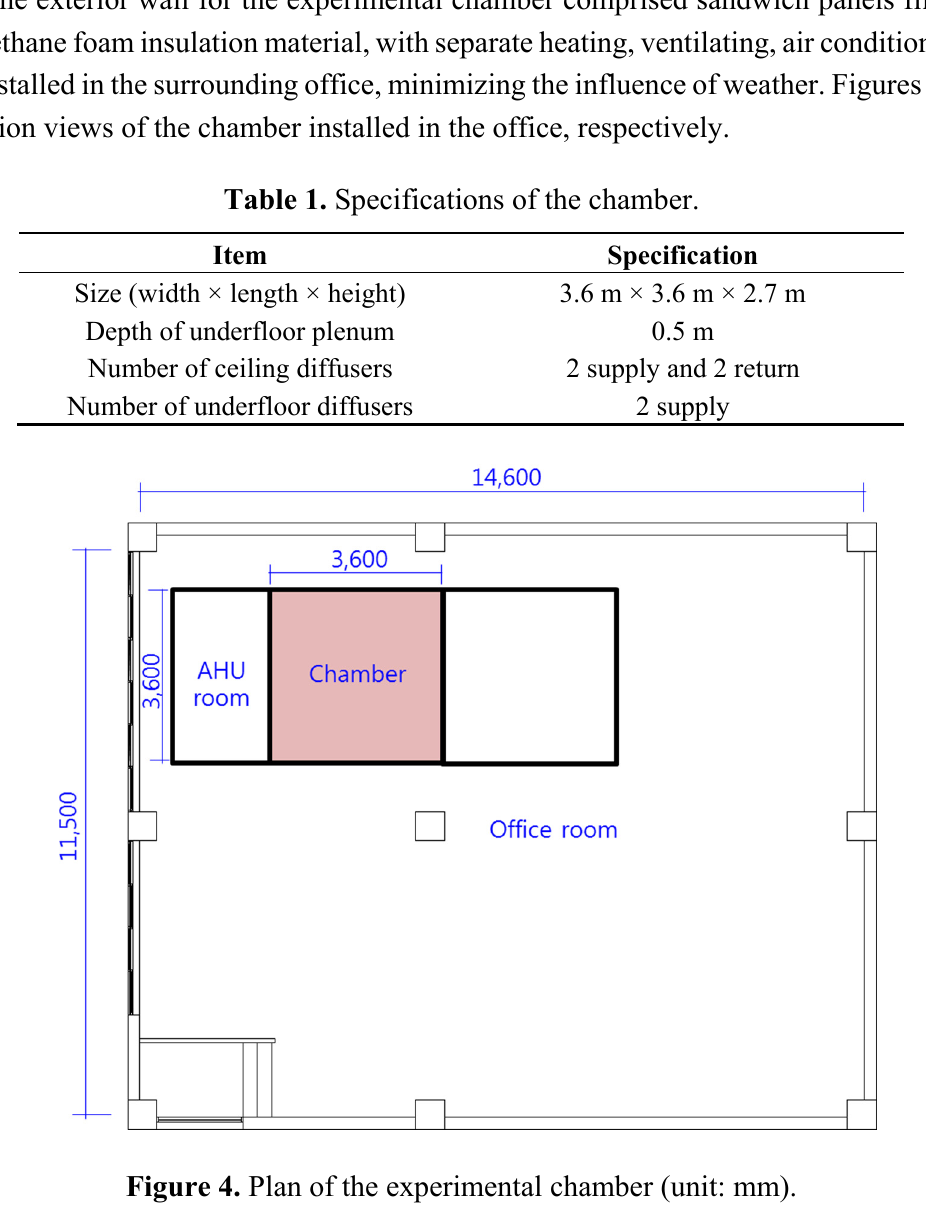
Figure 4. Plan of the experimental chamber (unit: